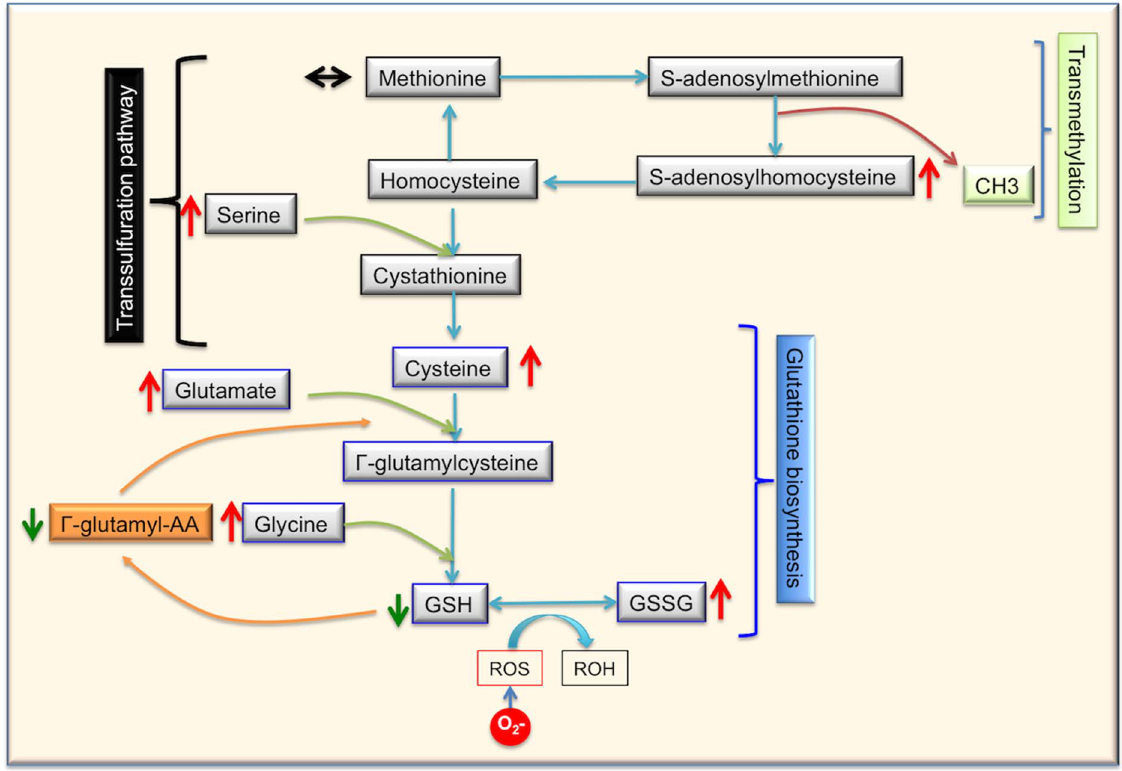
Figure 5. Methionine-Glutathione metabolism. This figures details the levels of various metabolites that were detected in the pathaway. Red arrow indicates higher levels, green arrow indicates lower levels and black arrow indicates no change in the levels of the metabolite.